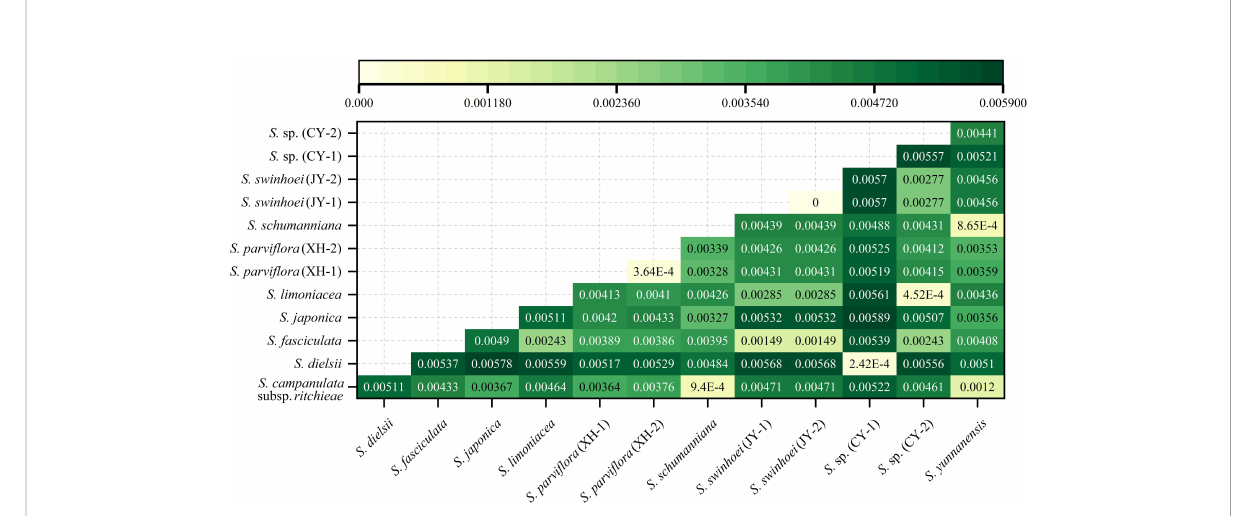
FIGURE 8 Genetic distances in chloroplast genomes of the genus Sabia . Distances from yellow to green and from light to dark indicate that the genetic relationships between species change from close to